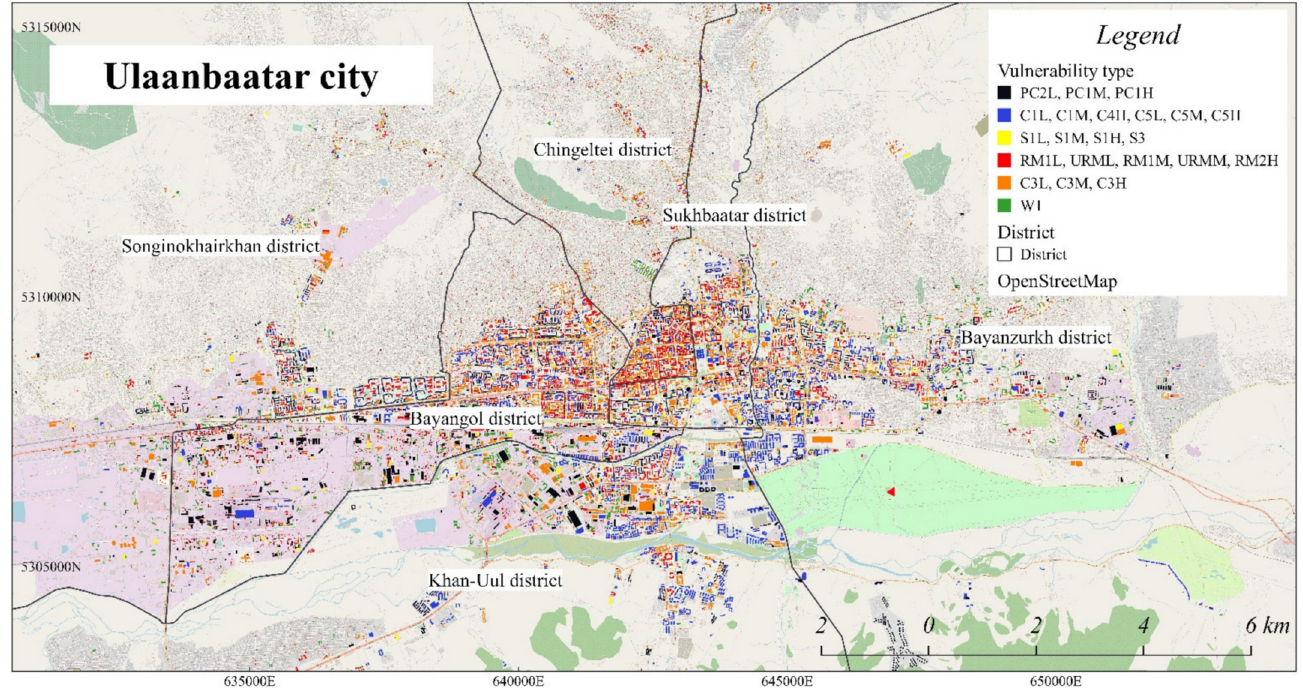
Figure 9. Distribution of building classes in UB.